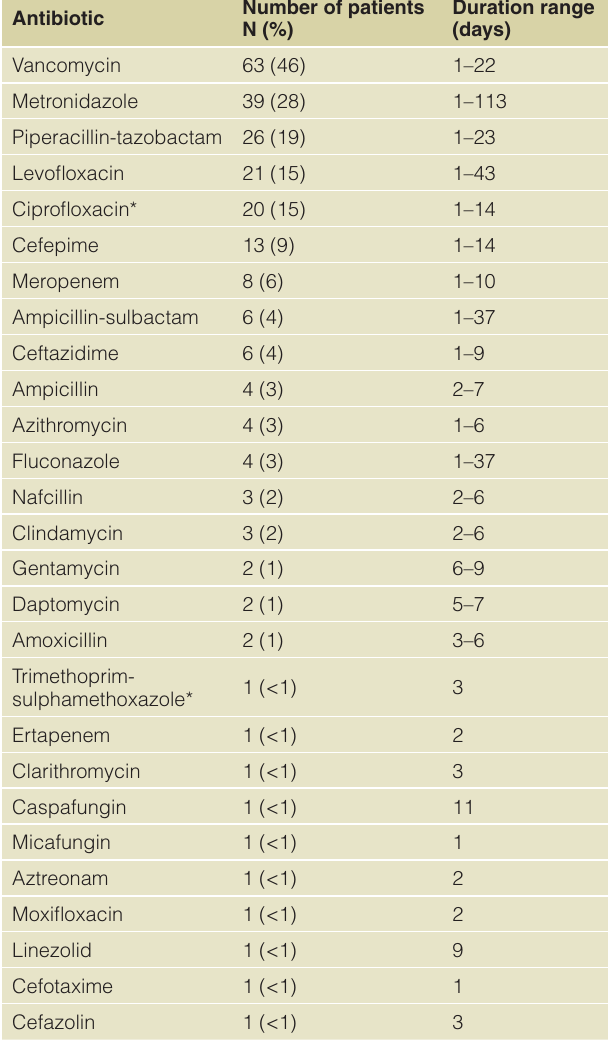
Table 3. Types of inpatient antibiotics prescribed in addition to ceftriaxone, with number of patients and percentage of total population (n=138) and range of duration of inpatient antibiotic coverage